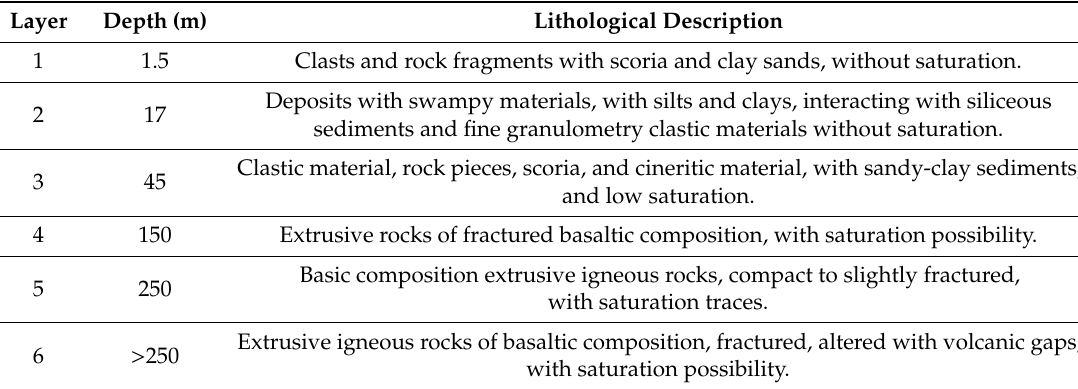
Figure 2. Geology in the urban area of Zamora, Mexico. Table 1. Lithological column of Zamora Municipality, Michoacán.